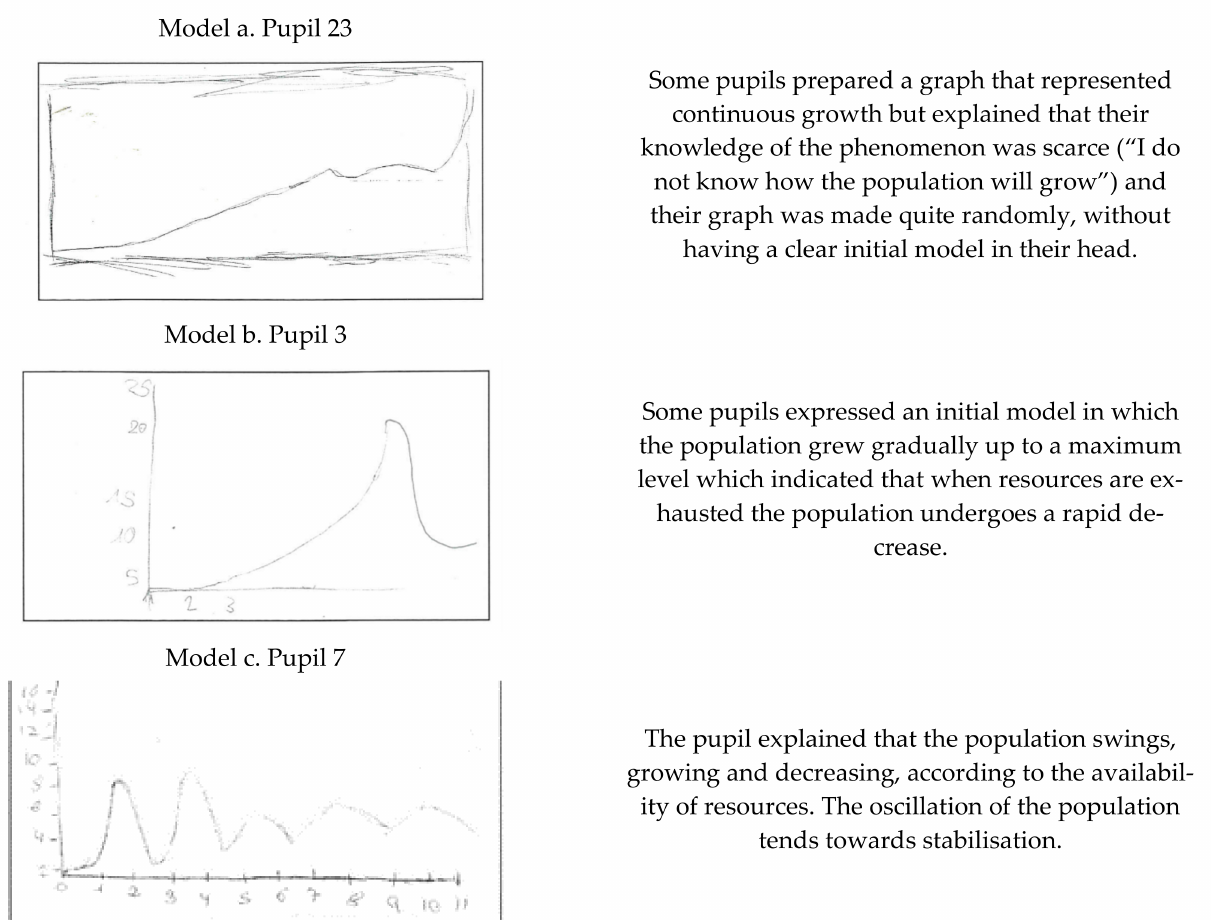
Figure 7. Graphic representations of pupils’ predictions of the evolution of the number of rabbits during the simulation in